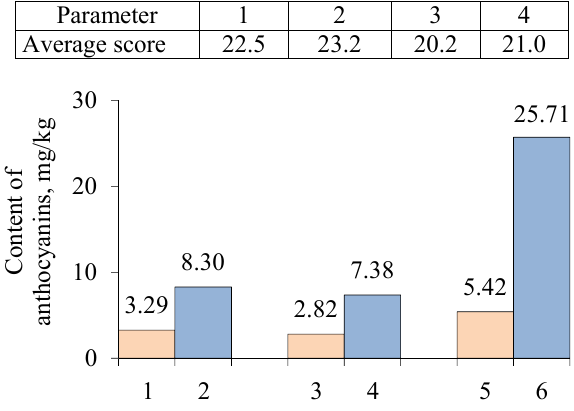
Table 5. Quality parameters of organoleptic indices (numbers 1–4 of products are according Table 1)